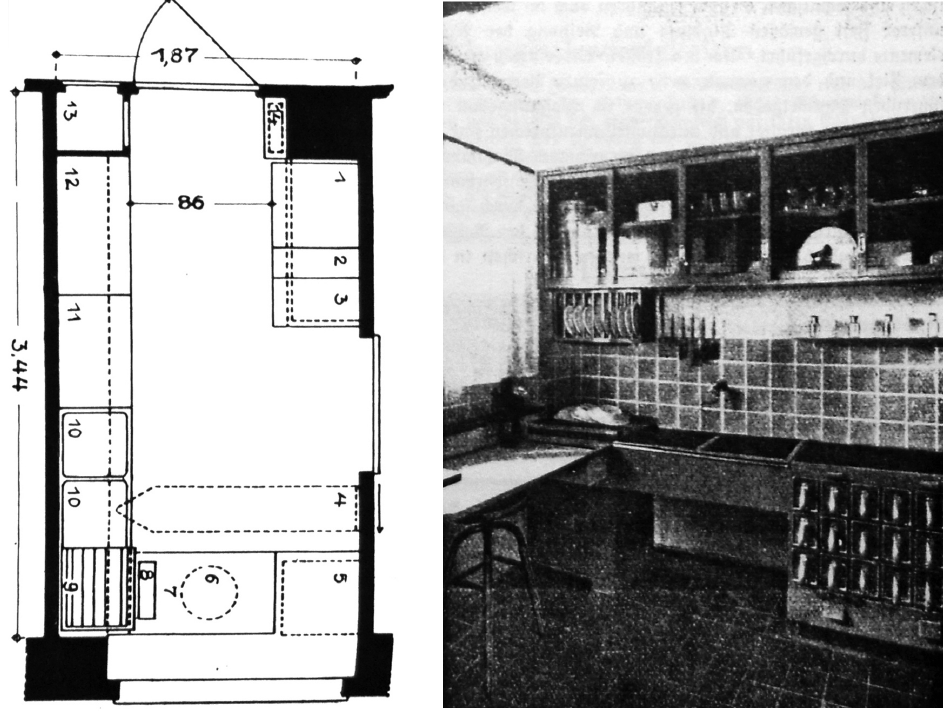
Figure 4. Frankfurt Kitchen , by Schütte-Lihotzky. Source: May (1926).